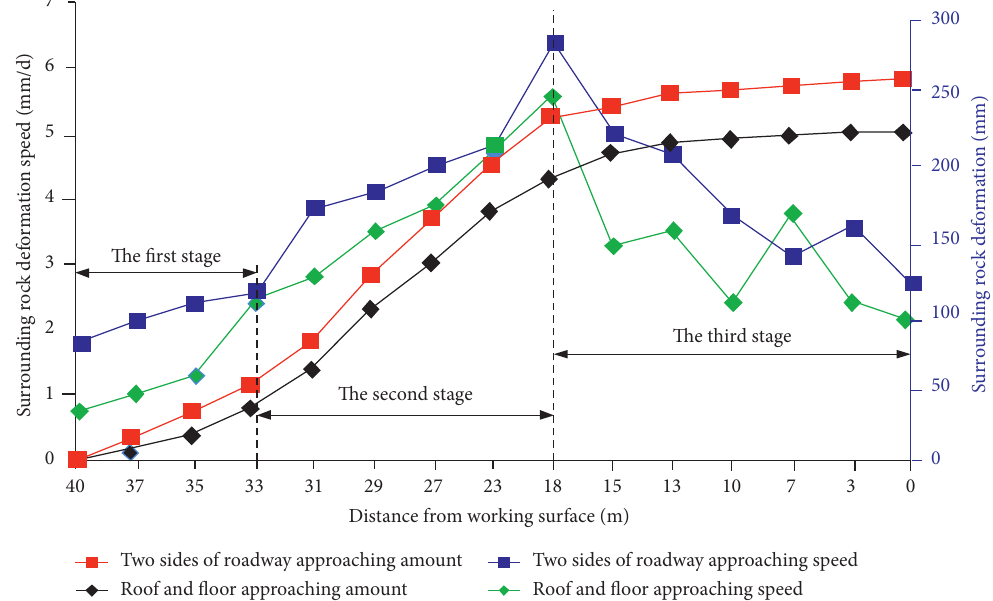
Figure 10: Surrounding rock deformation measured curve of coal transportation roadway in the working